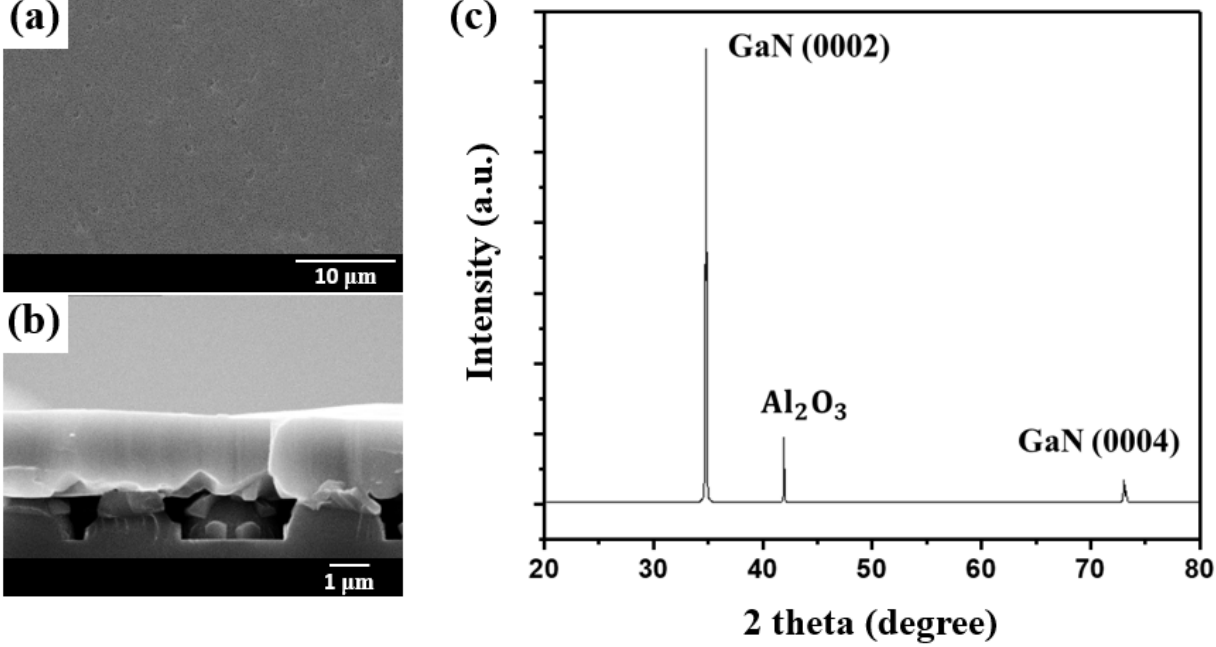
Figure 3. Top ( a ) and cross-sectional ( b ) SEM images of GaN template; ( c ) XRD pattern of GaN template with air tunnel.